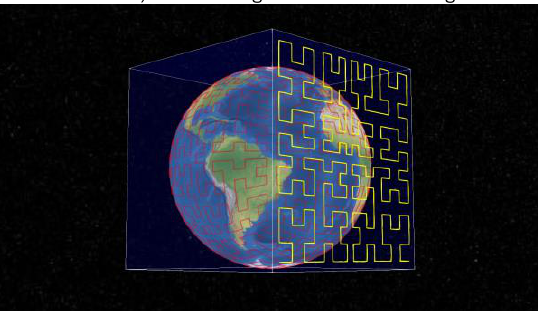
Figure 8 . Google S2 Hilbert SFC